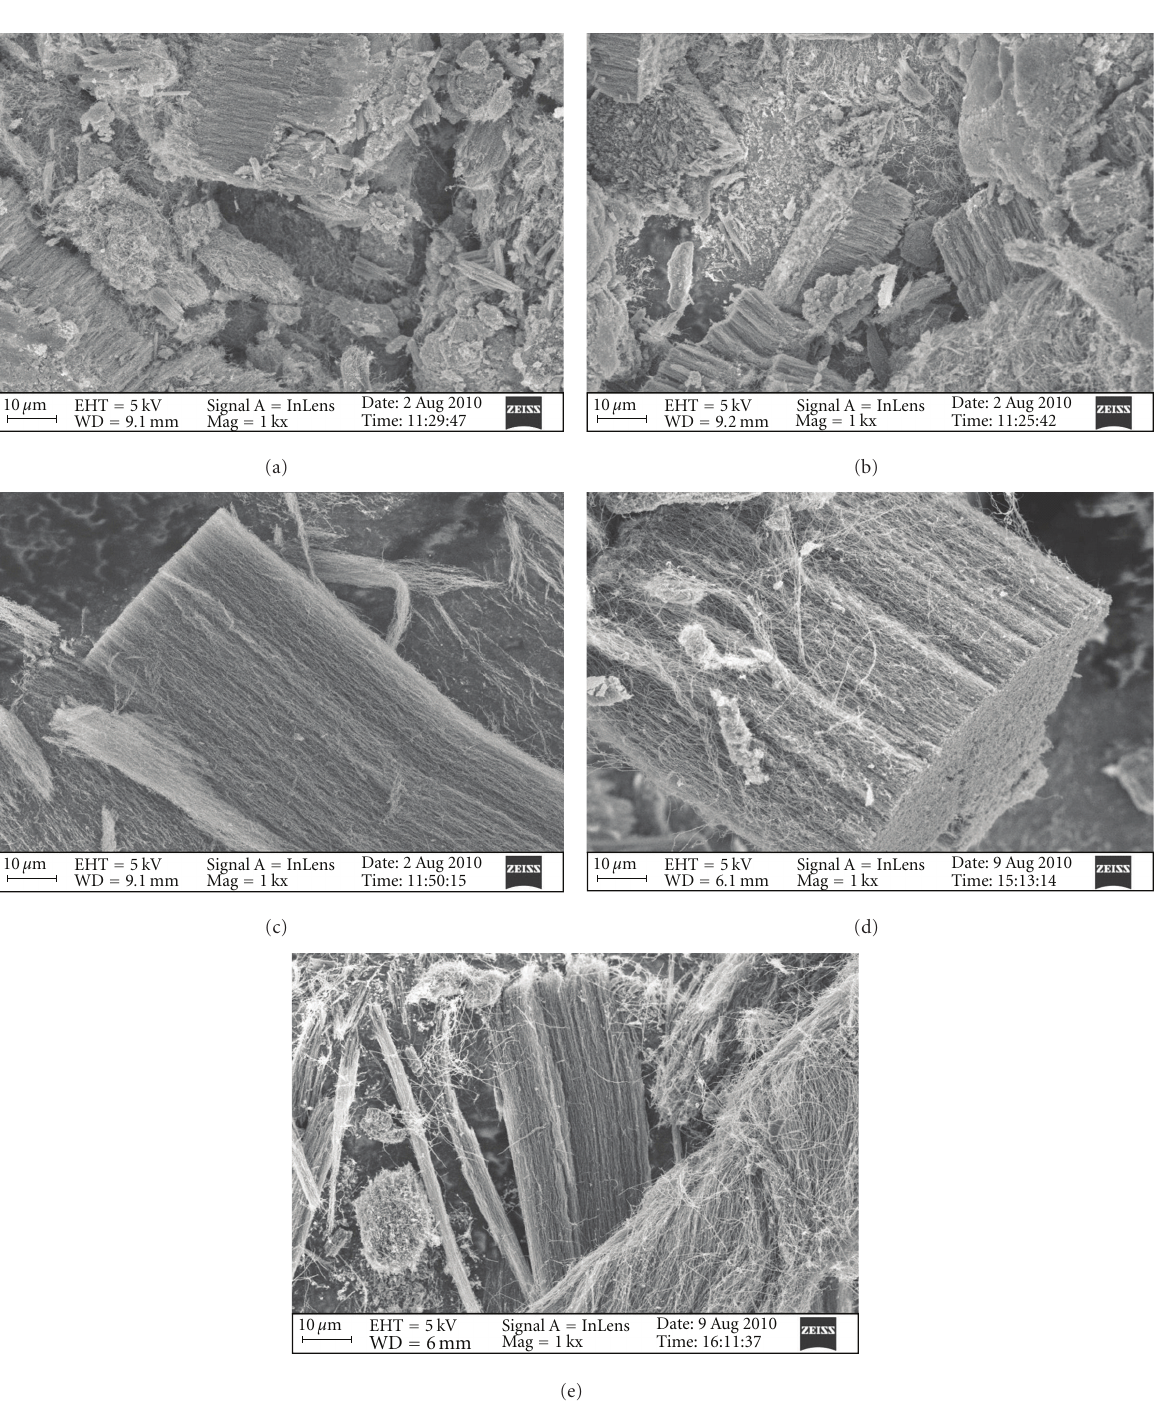
temperature from 800 to 900 ◦ C. The temperature at 800 ◦